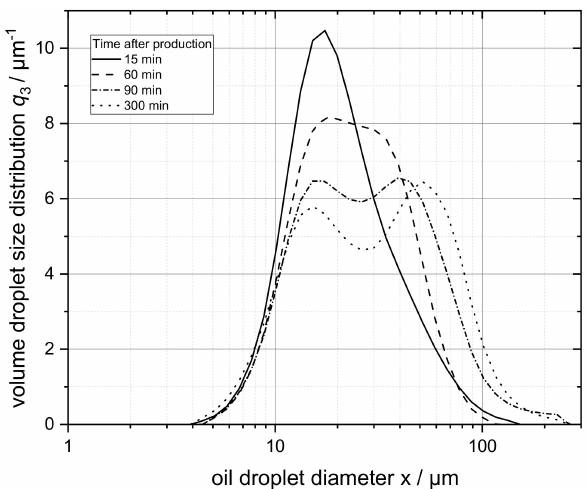
Figure 5. Oil droplet size distributions (DSD) of a double emulsion over time. Inner water / oil / outer water (W1 / O / W2) phase composition: W1: aqueous 0.35 wt % NaCl solution; O: canola oil with polyglycerol polyricinoleate (PGPR); W2: aqueous polyvinyl alcohol solution. Droplet sizes are measured with static laser di ff raction. Droplet growth may have occurred due to coalescence